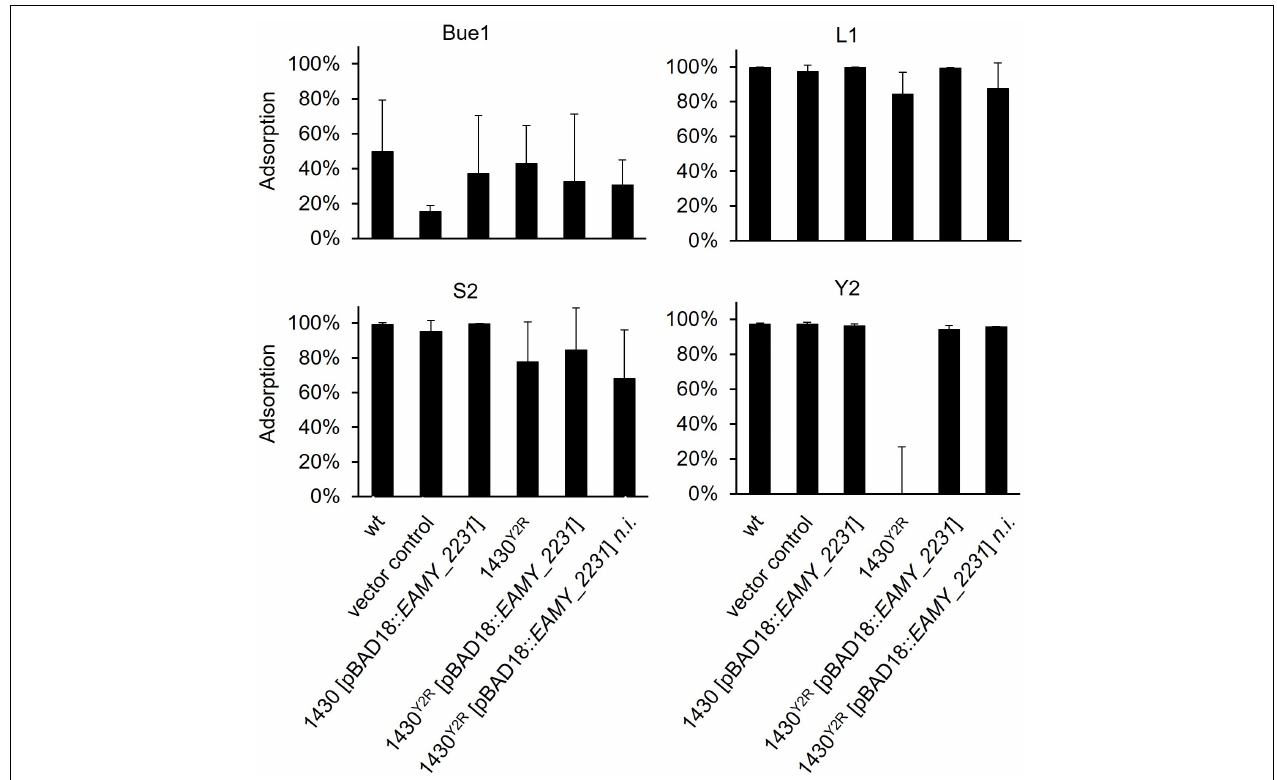
FIGURE 5 | Pull down experiment of all generated mutants applying L1, S2, Bue1, and Y2. The ability of these four phages to bind to the different mutants is illustrated. Error bars indicate standard deviation. Statistical analysis was done by an ordinary one way ANOVA p < 0.0001. Each sample was tested at least three times independently. wt, wild type; n.i., not